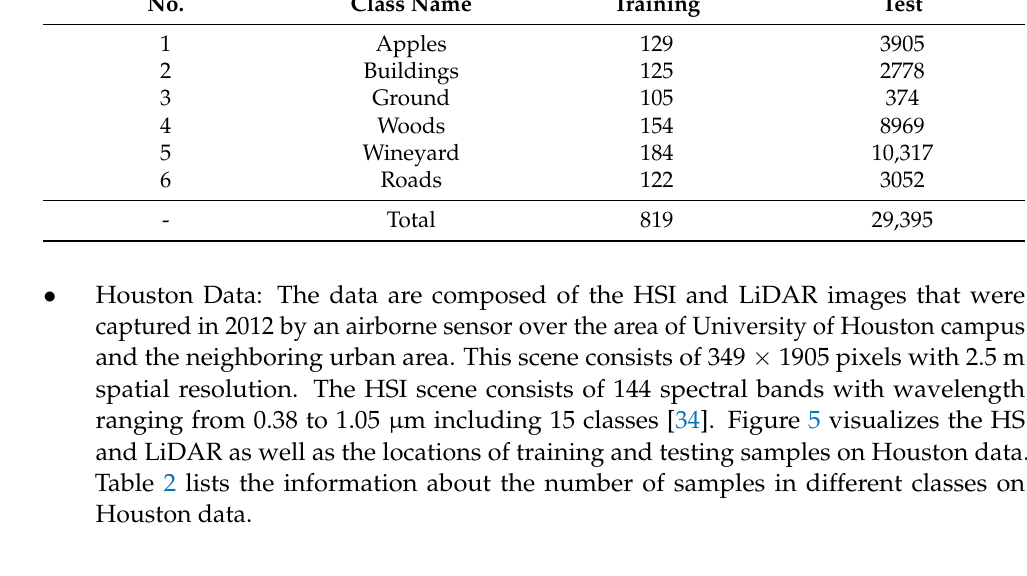
Figure 4. Visualization of Trento dataset: ( a ) false-color image (using 50, 45 and 5 bands as R, G and B, respectively); ( b ) LiDAR image; ( c ) training samples; ( d ) test samples; ( e ) color code. Table 1. List of the number of training and test samples for each class in Trento datasets.